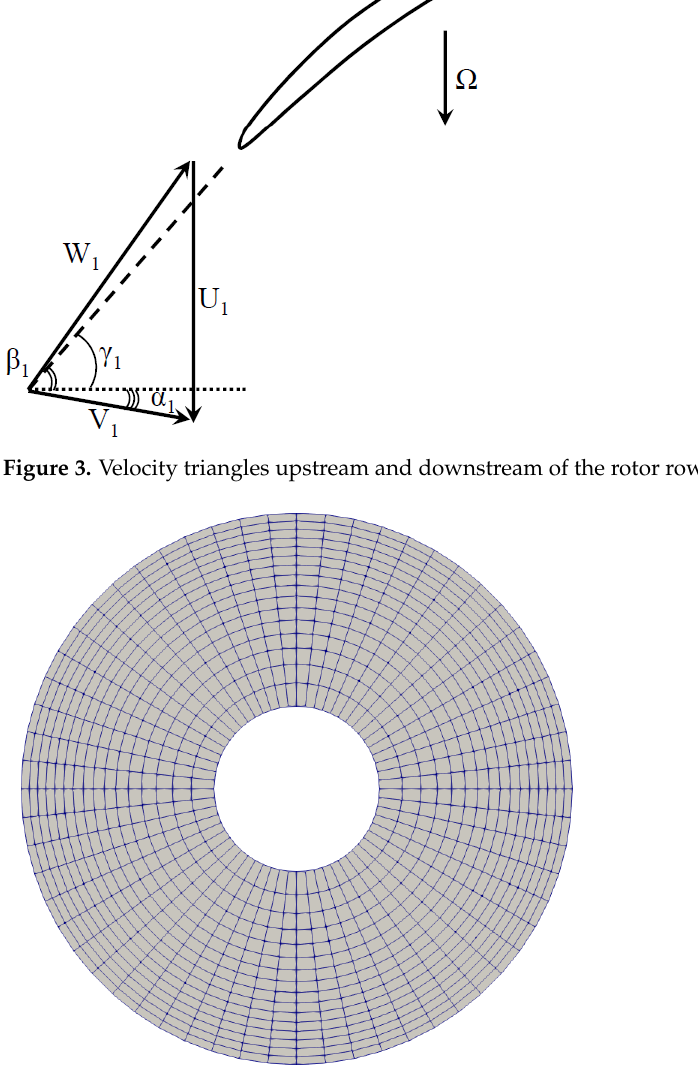
Figure 4. Example of coarsened mesh used for PC